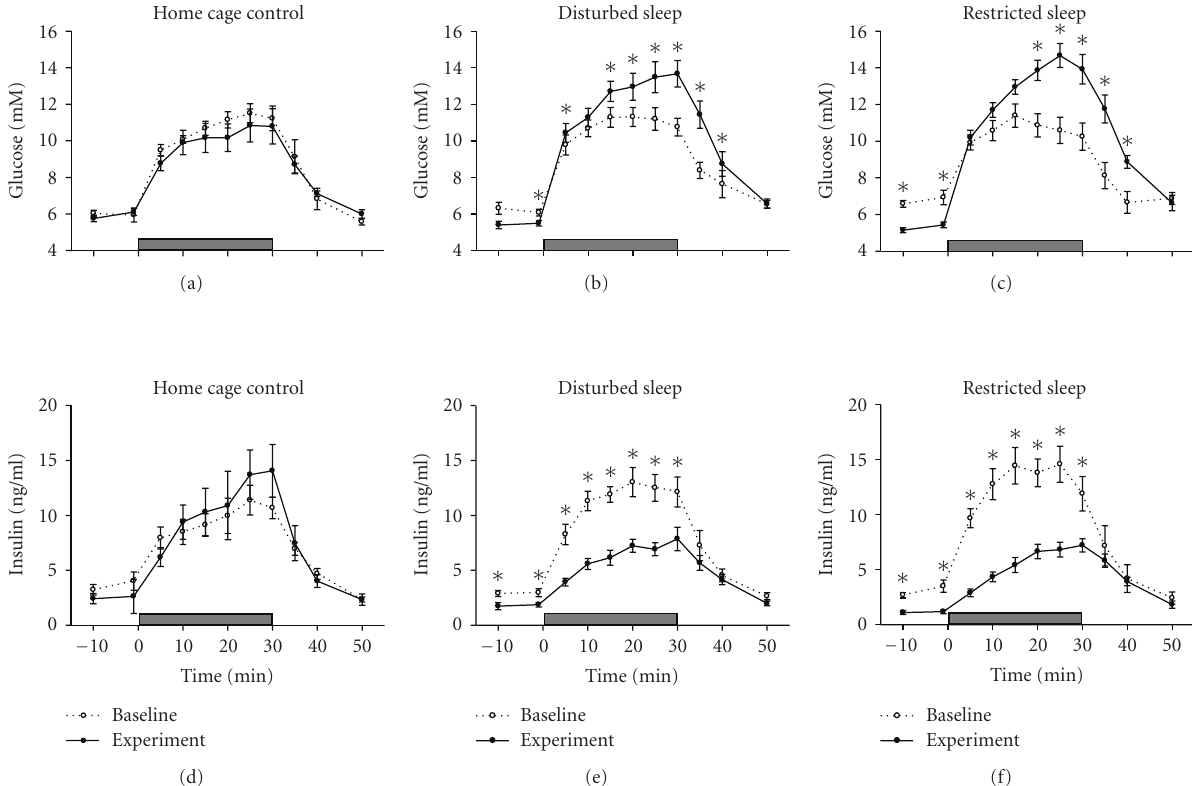
Figure 3: Blood glucose and plasma insulin levels in response to a 30-minutes intravenous glucose infusion after 8 days of sleep restriction (graphs (c) and (f), n = 11), sleep disturbance (graphs (b) and (e), n = 12), or control (graphs (a) and (d), n = 7). Each graph presents the glucose or insulin profiles under pre-experimental baseline conditions (Baseline: open circles) and after 8 days of sleep disturbance (Experiment: closed circles). The horizontal grey bars at the bottom of each graph represent the 30 minutes of 15% glucose infusion. Data are average values ± SEM. Asterisks indicate a significant di ff erence between baseline and experimental conditions ( ∗ P < .05).